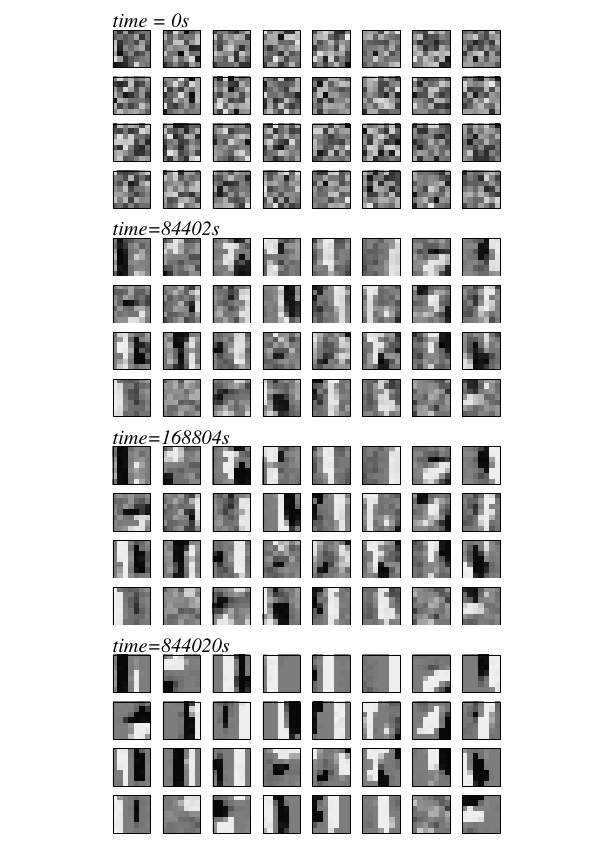
Figure 24 | evolution of 7 × 7 pixel receptive Fields through unsupervised STDP training with Aer retina data observing life scenes. Weights are shown at different stages of training: initial random weights, after half a training epoch, after one training epoch, and after five training epochs.